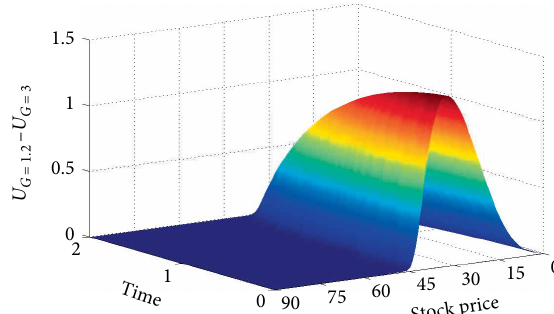
Figure 7: with 𝑟 = 0.05, 𝛾 = 0.06, 𝐶 = 0.03, 𝑈 𝐺=1.2 − 𝑈 𝐺=3 𝑀 = 1, 𝑌 = 1.5,𝑇 = 2, 𝐾 = 50